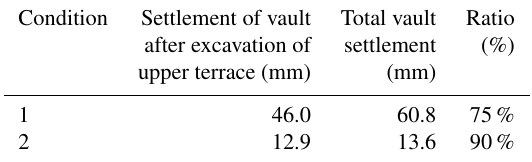
Table 7. Calculation